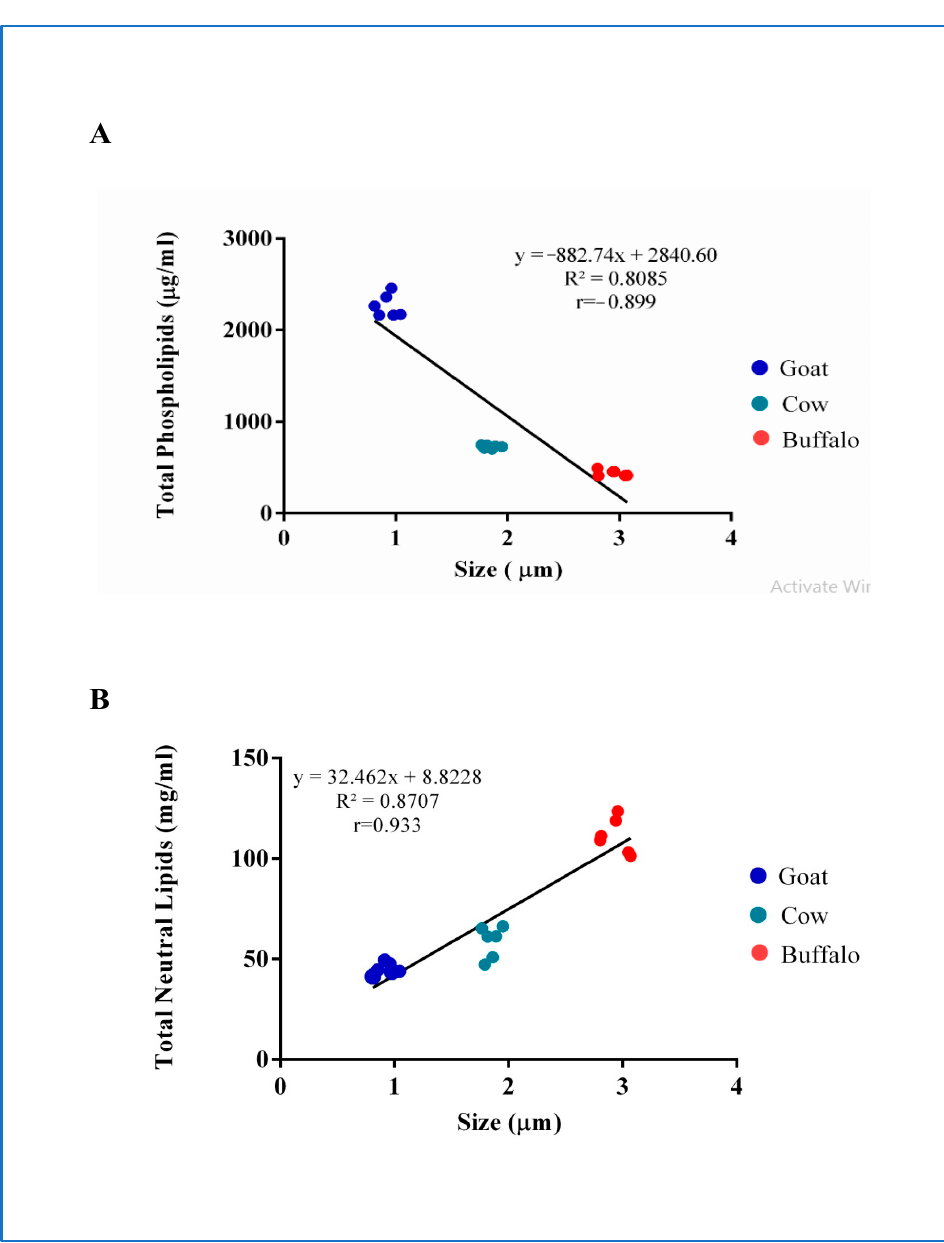
Figure 6. Correlation ( r ) between milk fat globule size of animal groups measured by dynamic light scattering and ( A ) total polar lipids and ( B ) total neutral lipids present in cow, water buffalo, and goat.